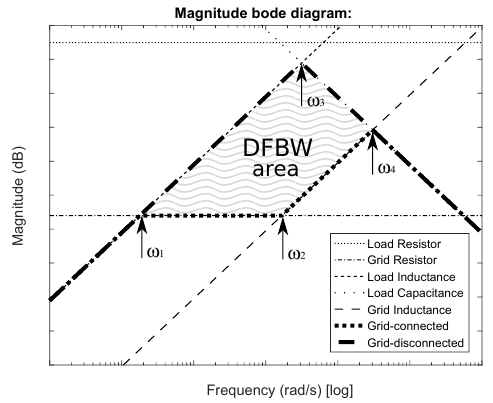
Figure 9. Conceptual asymptotic magnitude Bode diagram of the PCC impedance. DFBW, detection frequency bandwidth.